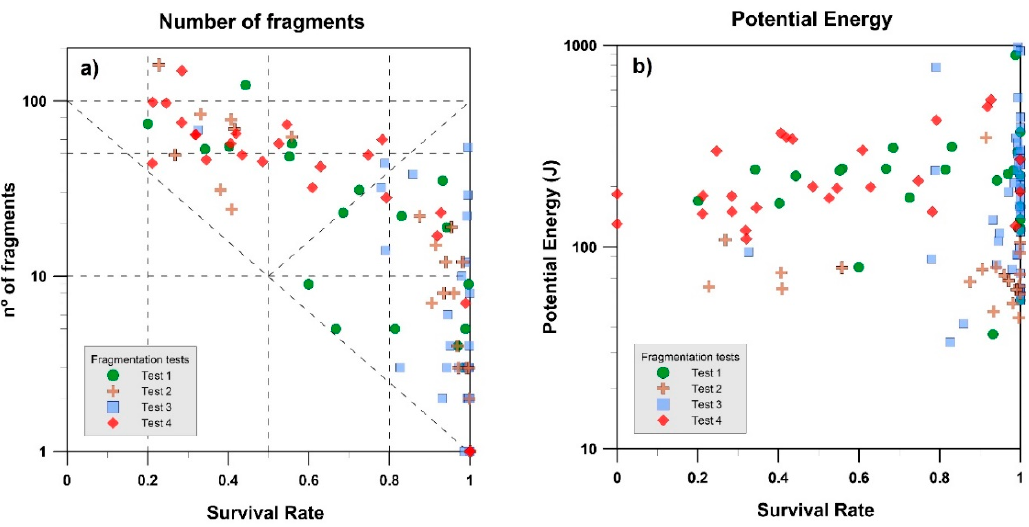
Figure 17. Survival rate versus: ( a ) the number of fragments generated in each tested block: and ( b ) versus the potential energy.